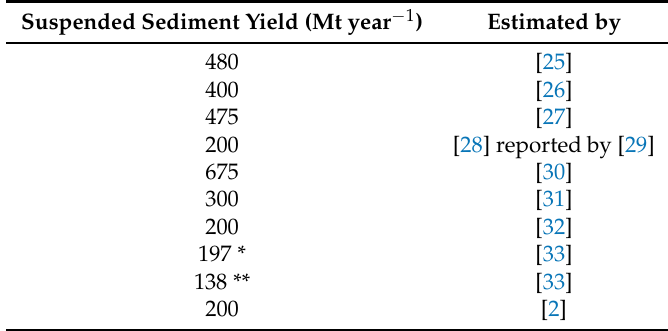
Table 1. Estimates published on the suspended sediment load (SSL) of the upper Indus